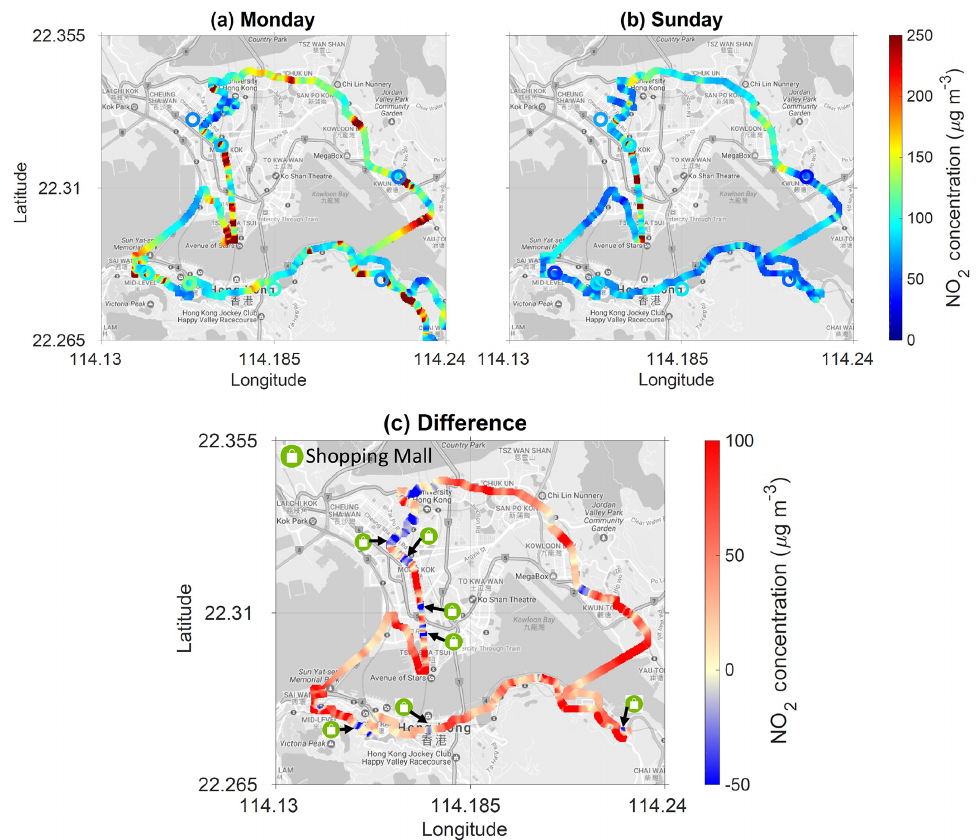
Figure 11. Mobile CE-DOAS measurement of on-road NO 2 on (a) Monday (6 March 2017) and (b) Sunday (5 March 2017). Coinciding NO 2 concentrations measured by the seven EPD stations are shown on the map as circle markers for reference. The colour scale of the EPD measurements is the same as the mobile measurements. Panel (c) shows the differences between Monday and Sunday. The markers indicate the location of major shopping